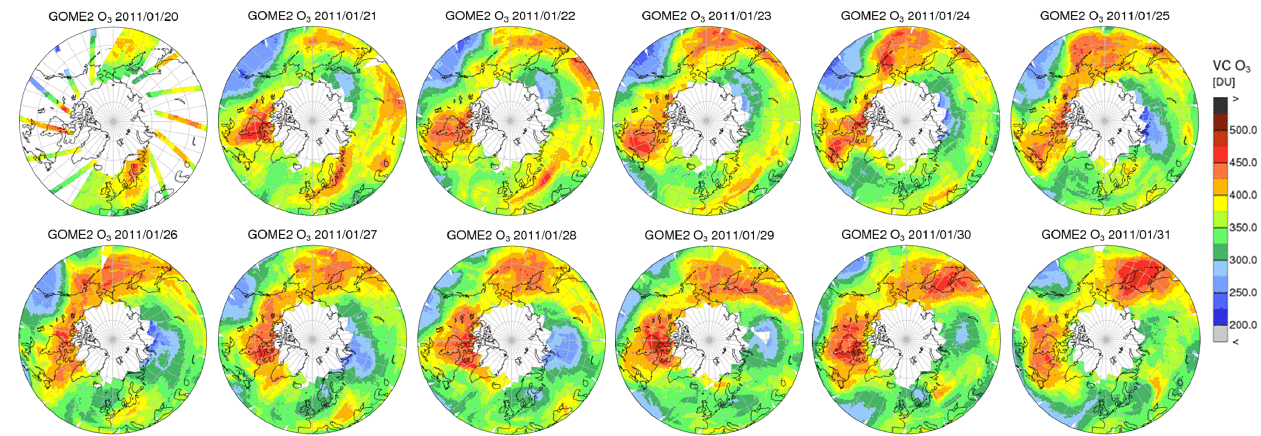
Fig. 13. Daily maps of total ozone measured by GOME-2 between 20 and 31 January 2011. On 21 January 2011 column ozone was substantially decreased by more than 70DU over central Siberia north of Sakhalin. The low ozone area propagated westward with time reaching the Ural region on 27 January. Then the area of low ozone propagated eastward and dissolved at approximately 90–100 ◦ E, 60 ◦ N on 30 January 2011.